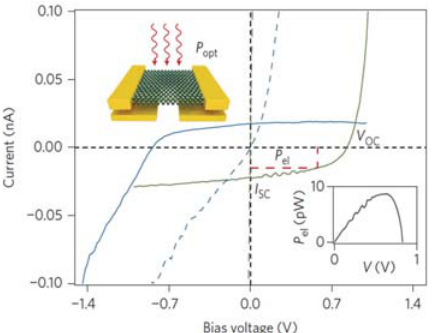
Figure 13. I–V characteristics of monolayer WSe 2 photodiode under a halogen lamp with 1400 W/m 2 . The biasing conditions are p–n (solid green line; V G1 = − 40 V, V G2 = 40 V), n–p (solid blue line; V G1 = 40 V, V G2 = − 40 V), and p–p (dash blue line; V G1 = V G2 = 40 V). The red dashed rectangle in the main panel shows the maximum power conversion efficiency area (P el ). Top inset: Schematic of WSe 2 monolayer device with split gate electrodes. Lower inset: electrical power (P el ) versus voltage under incident illumination. Reproduced with permission from [157], Nature Publishing Group, 2014.